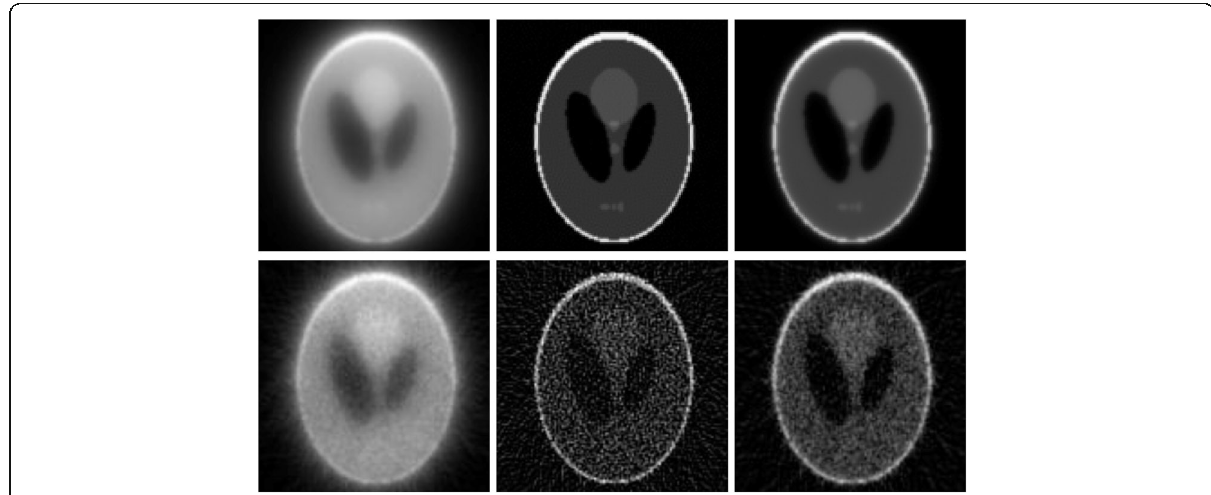
Fig. 7 Two-dimensional reconstructions. Upper row: Noiseless simulations; Lower row: Noisy simulations; Left column: Equivalent time-of-flight backprojection; Middle column: Backprojection filtering (BPF) reconstructions; Right column: BPF reconstructions with noise control window function